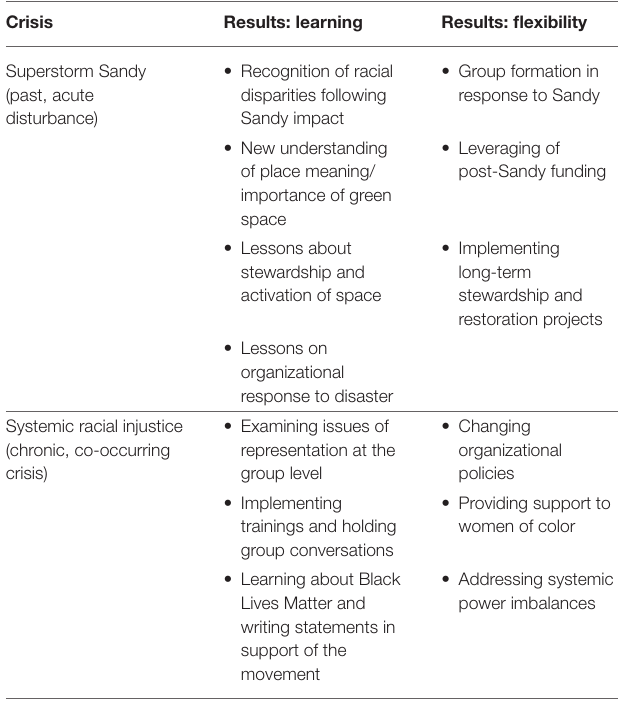
TABLE 2 | Learning and flexibility characteristics of stewardship groups by